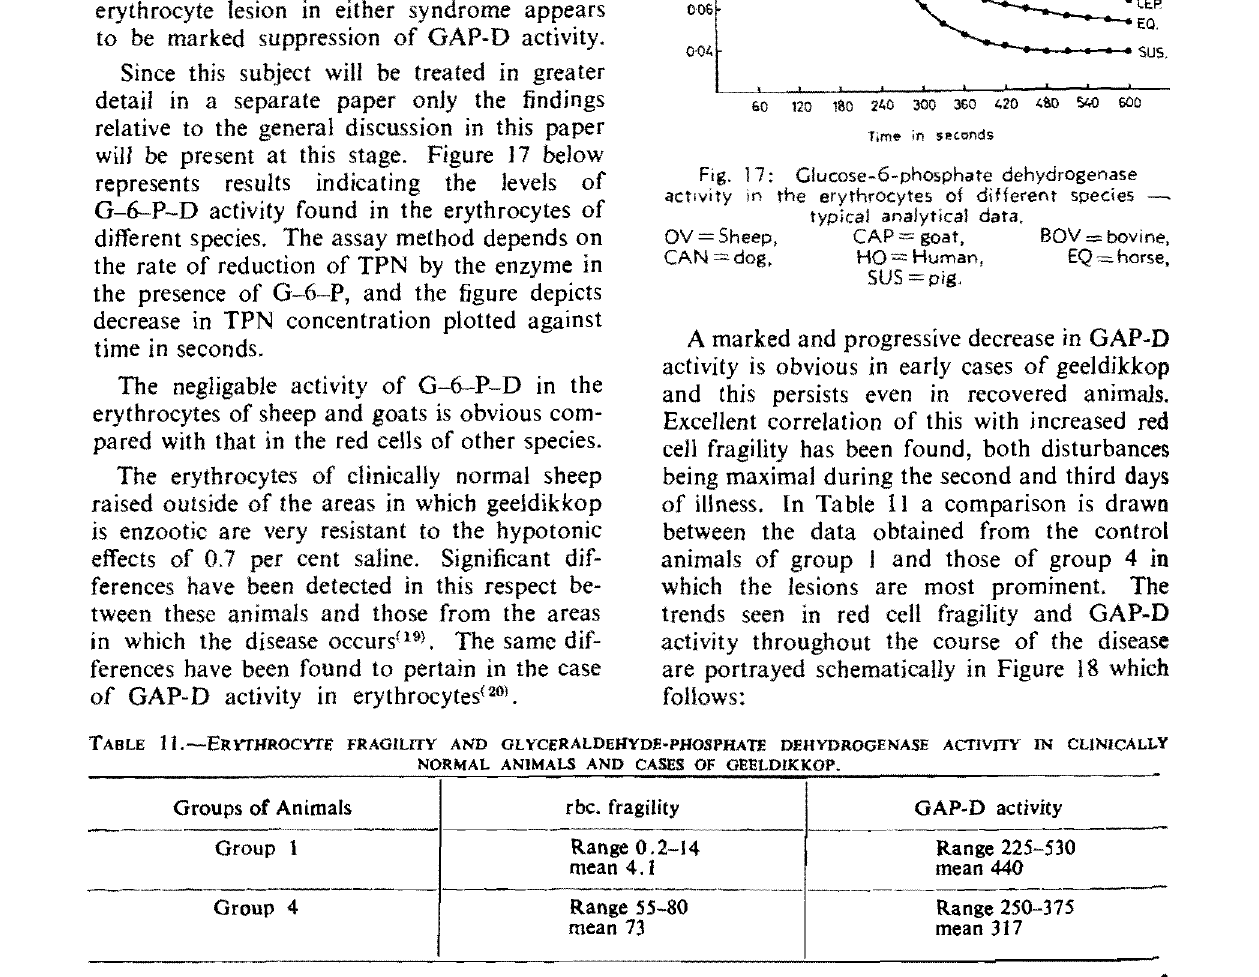
TABLE 11.-ERYrHROCYrE FRAGILITY AND GLYCERALDEHYDE-PHOSPHATE DEHYDROGENASE ACTIVITY IN CLINICALLY Groups of